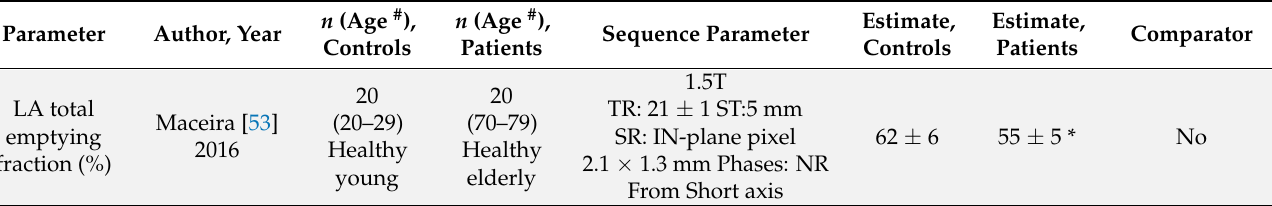
Table 9. LA time/volume curves—reservoir